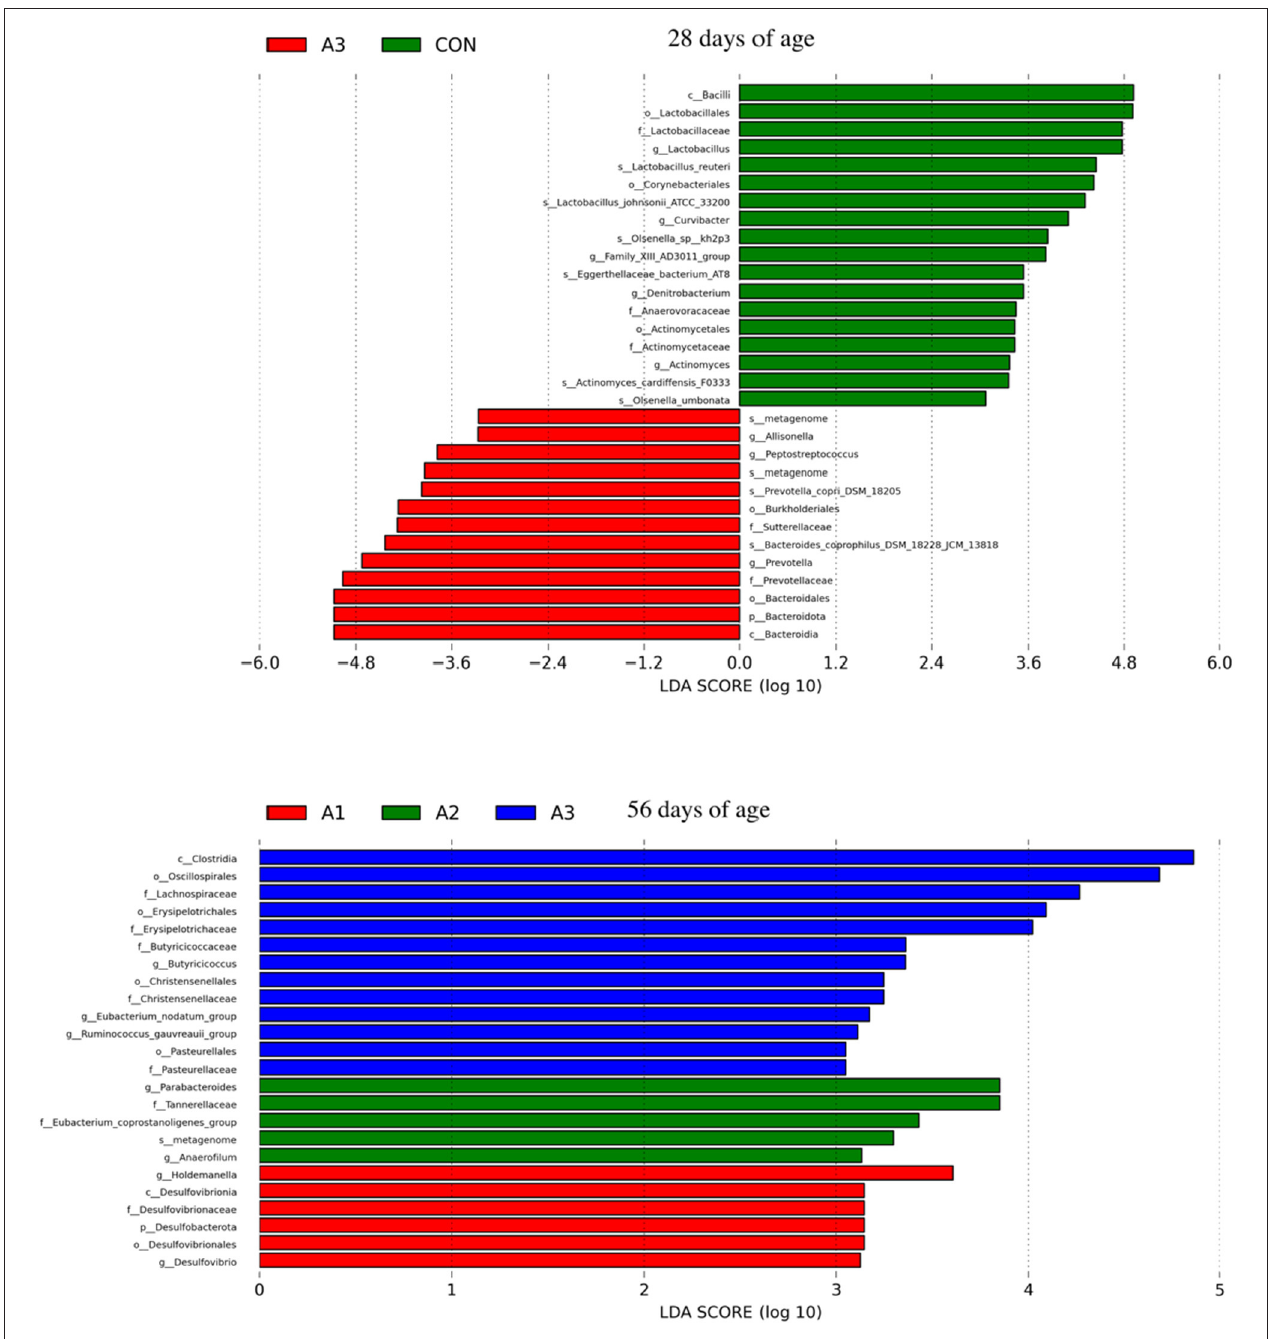
FIGURE 4 | The potential biomarkers were defined by LEfSe at 28 and 56 days of age. The significantly different taxa are signified by different colors representing the four groups. Histogram of the LDA scores for differentially abundant features among groups. The threshold on the logarithmic LDA score for discriminative features was set to 3.0. CON, the dosage of B4 is 0mg / day; A1, the dosage of B4 is 15mg / day; A2, the dosage of B4 is 30mg / day; A3, the dosage of B4 is 45mg /